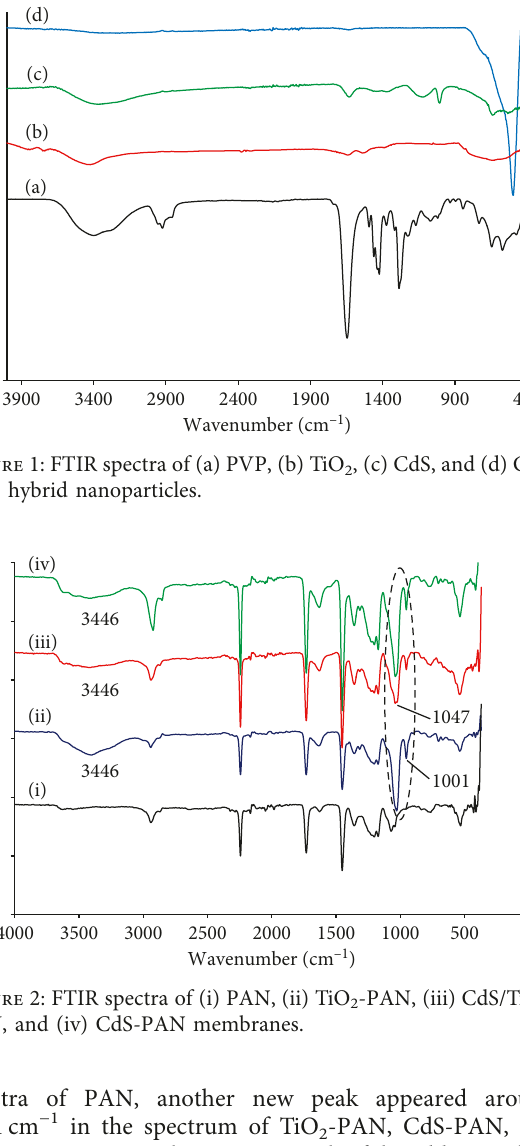
2 -PAN, (iii) CdS/TiO 2 -